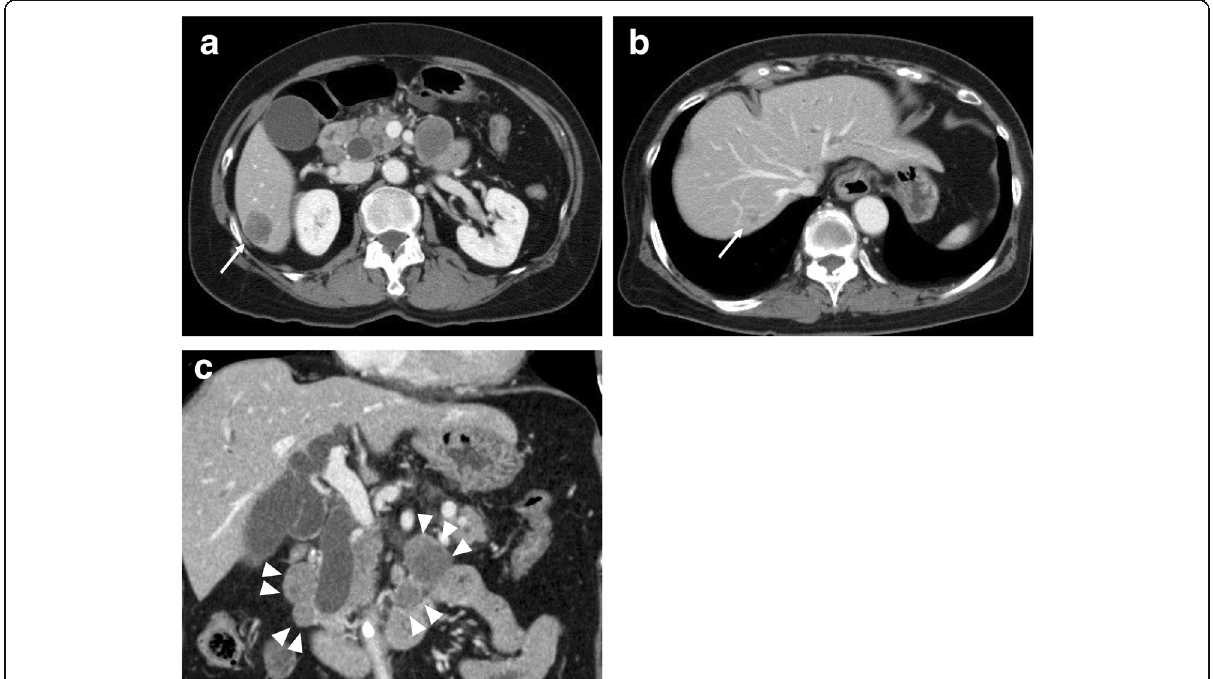
Fig. 2 a , b Abdominal computed tomography showed dilatation of the intrahepatic and extrahepatic bile duct. Two hypovascular lesions were detected in the liver (arrow). c Multiple enlarged lymph nodes were present around the distal bile duct and superior mesenteric artery